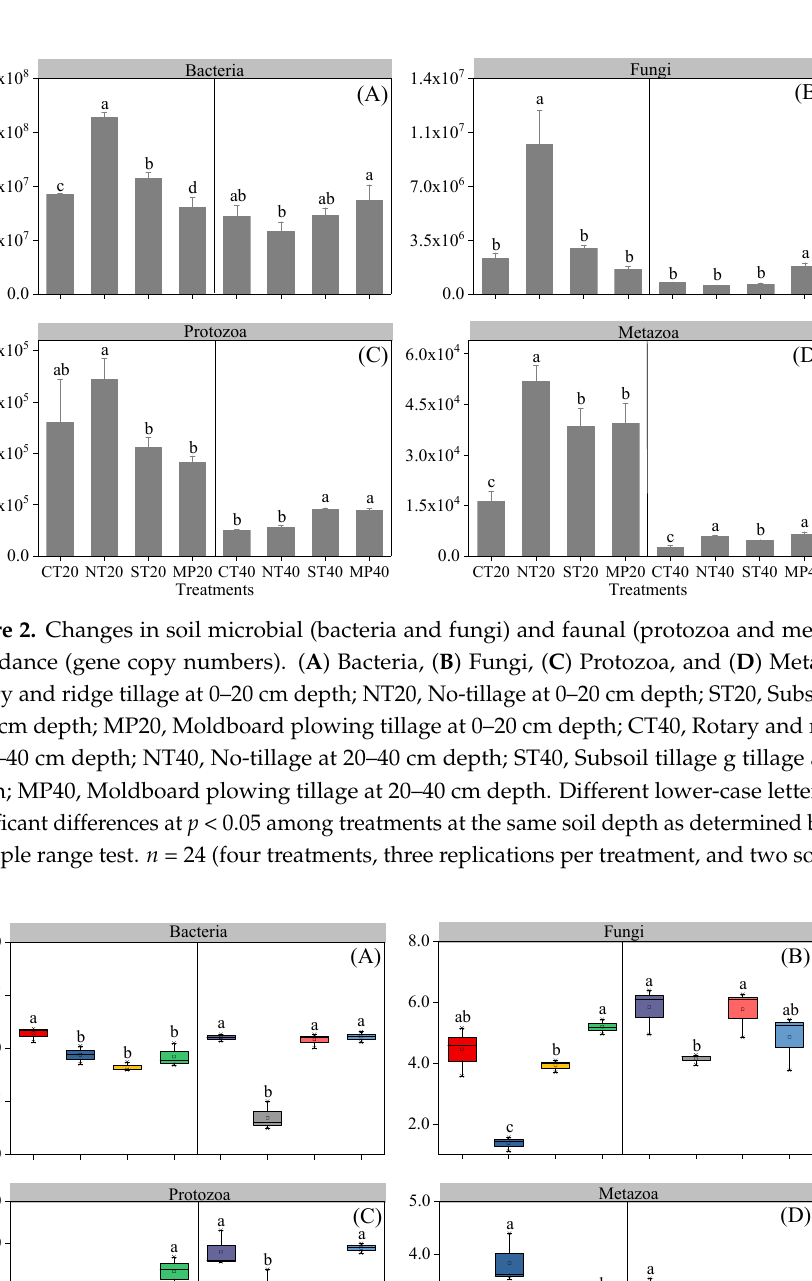
NT40, No-tillage at 20–40 cm depth; ST40, Sub–soiling tillage at 20–40 cm depth; MP40, Moldboard